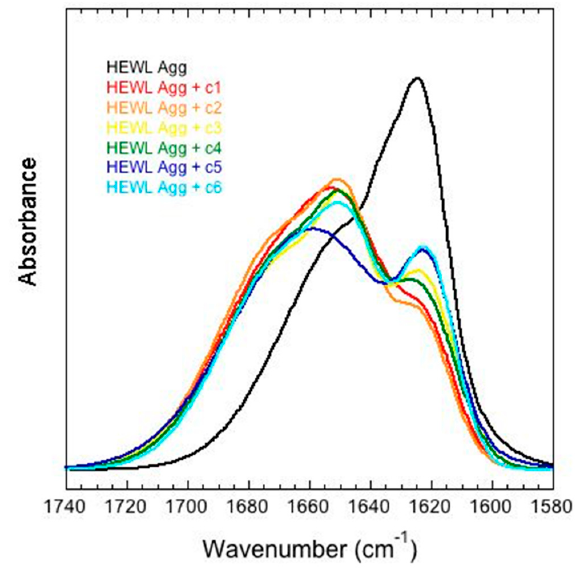
Figure 4. Inhibitory effects of the compounds 1–6 on the formation of β -sheet secondary structure of HEWL monitored by FTIR. HEWL amyloid fibril formation was pre-incubated at 2 mg/mL (140 µM), in 50 mM glycine buffer, pH 2.5, and 57 °C, under stirring (250 rpm), for 48 h in the presence of 0.32 µ M compounds 1 – 6 , centrifuged at 13,000 × g for 10 min and resuspended in D 2 O to a final HEWL concentration of 27.8 mg / mL. Blank-subtracted, baseline-corrected, and normalized FTIR spectra (amide I region) of HEWL aggregates without (black) or with compound 1 (red), compound 2 (orange), compound 3 (yellow), compound 4 (green), compound 5 (blue), and compound 6 (indigo).